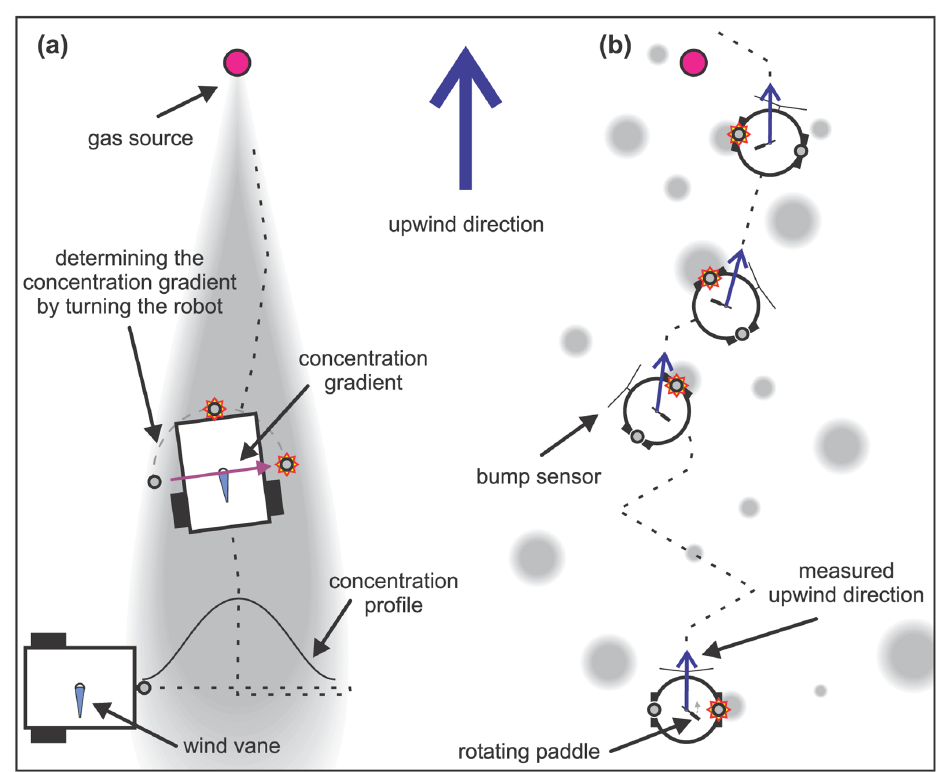
Figure 13 . (a) Plume-centred upwind search by Russell et al. [77]. (b) Bombyx mori algorithm as implemented by Russell and co-workers in [75]. Possible trajectories are plotted on top of the idealised gas distribution assumed by the particular